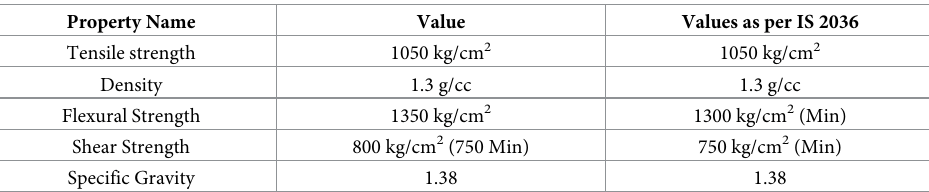
Table 4. Properties of